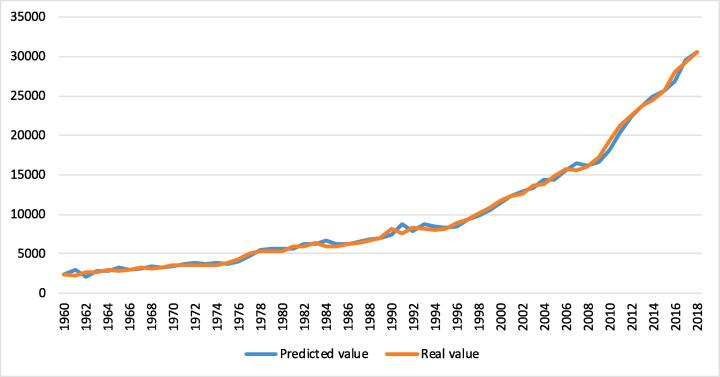
Validity of the ARIMA model of consumption prediction.